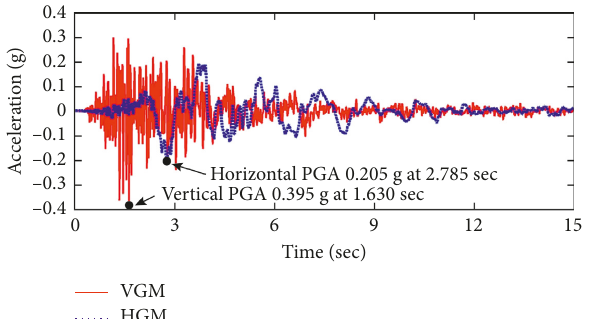
Figure 3: Horizontal and vertical ground motions, Morongo Valley Fire Station, N. Palm Springs earthquake